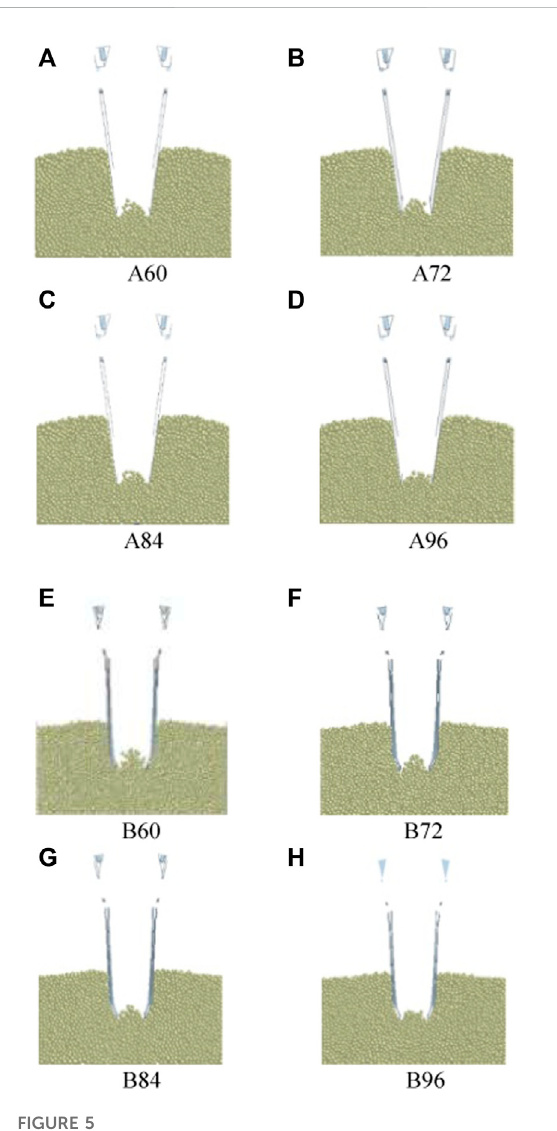
FIGURE 5 Effect of different planting frequencies on hole formation.